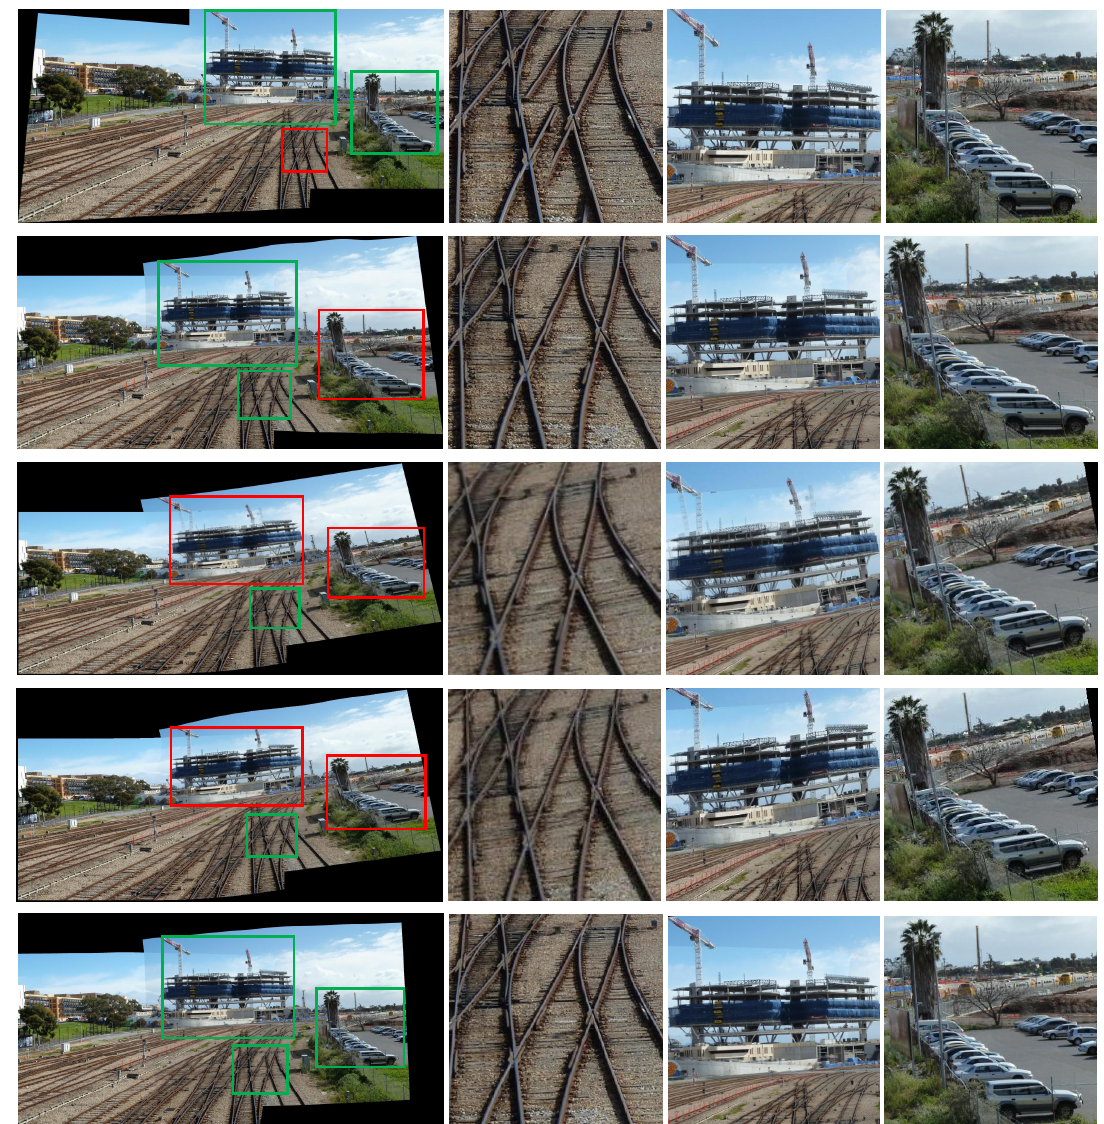
Figure 6. Comparison with the other image stitching algorithms on the Railtracks images. From first row to last row, the results are: ICE, APAP, SPHP, SPHP+APAP, and our